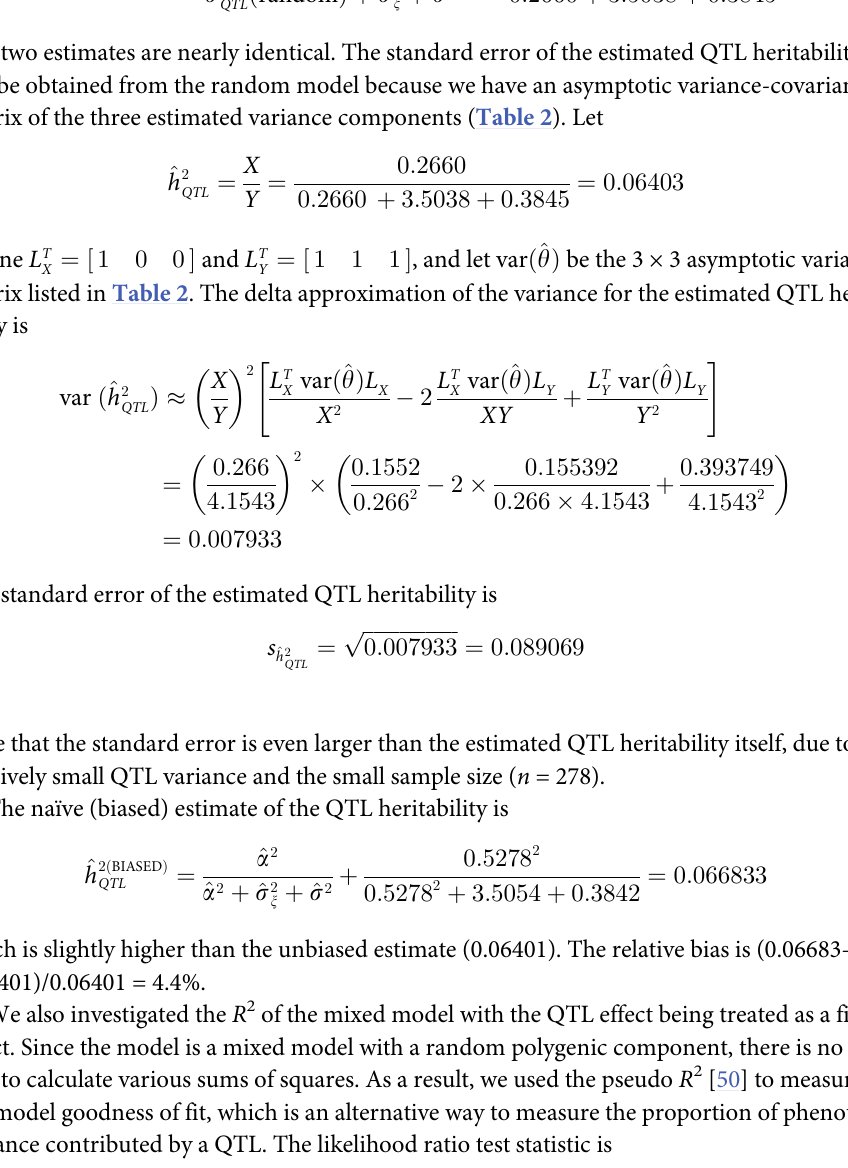
Table 2. Asymptotic variance-covariance matrix of the estimated variance components for trait KGW from the random model analysis (REML) for bin 725 of the rice population ( s 2 ¼ a 2 ). a var ð ^ y Þ s 2 a s 2 x σ 2 0.15520 0.00036 -0.00020 s 2 a 0.00036 0.28840 -0.02950 s 2 x σ 2 -0.00020 -0.02950 0.00881